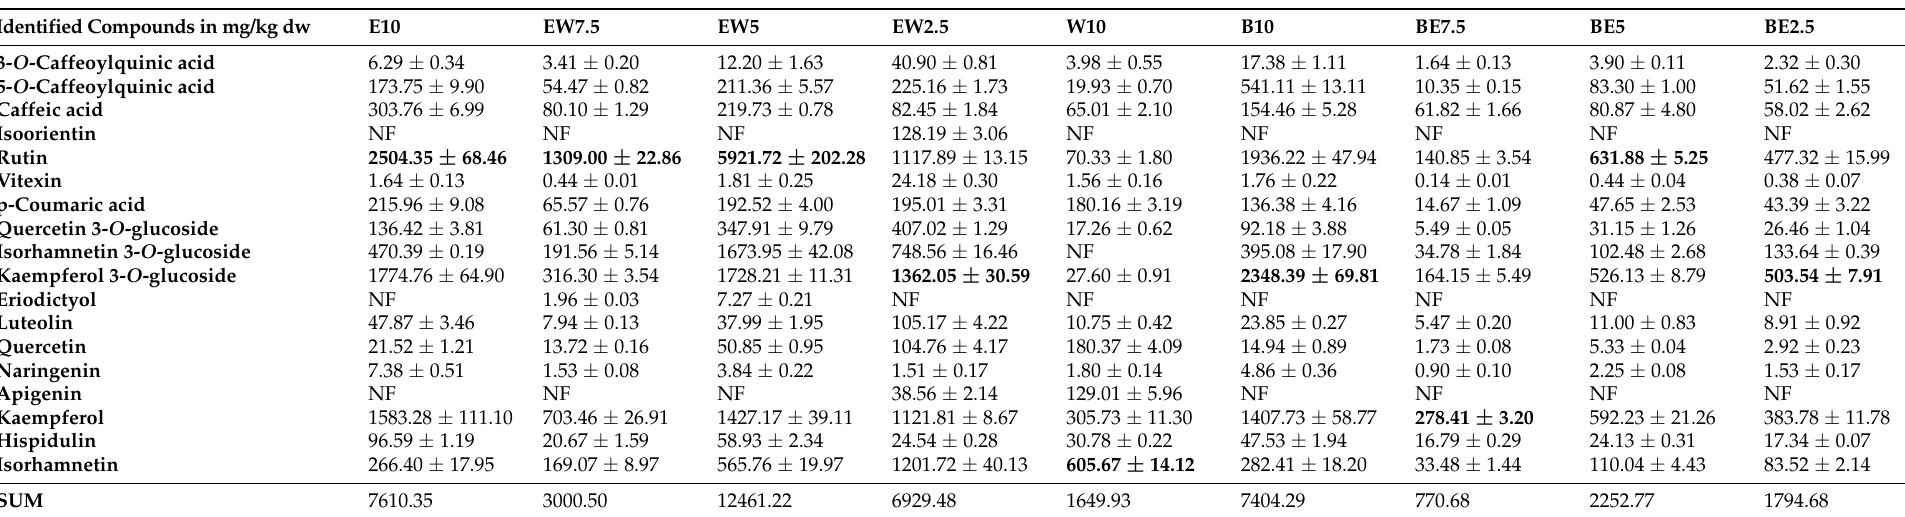
Table 2. Phenolic constituents of the Allium scorodoprasum flower extracts in mg/kg dw. Identified Compounds in mg/kg